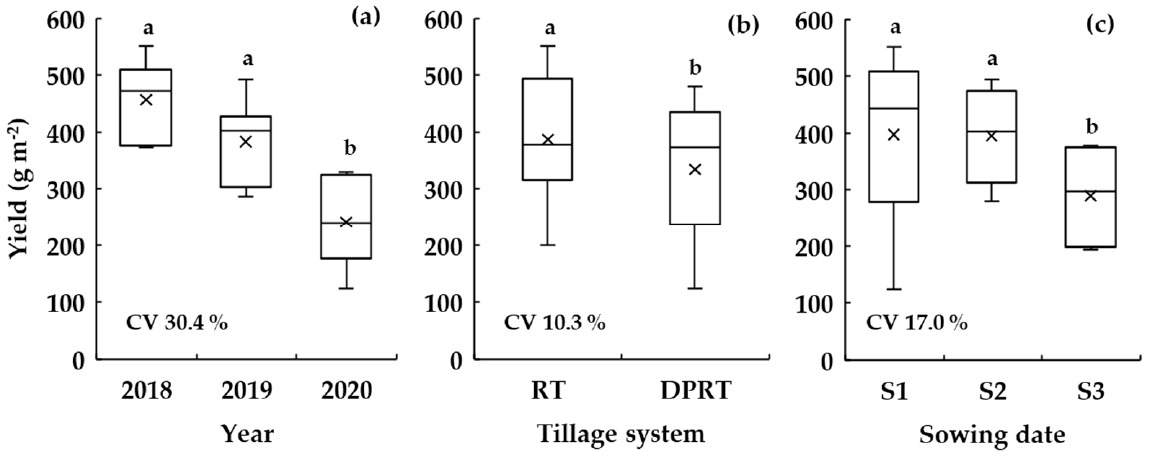
Figure 4. Yields [mean ( × ) and median with 25–75% IQR in boxes] of double-crop soybean grown in drained paddy fields over three crop seasons ( a ), tillage systems ( b ), and sowing dates ( c ). RT and DPRT refer to rotary tillage and deep plowing followed by rotary tillage, respectively. S1, S2, and S3 refer to sowing date on 10–15 June, 25–30 June, and 10–15 July, respectively. Different letters above the boxes indicate statistically significant differences ( p < 0.05). CV, coefficient of